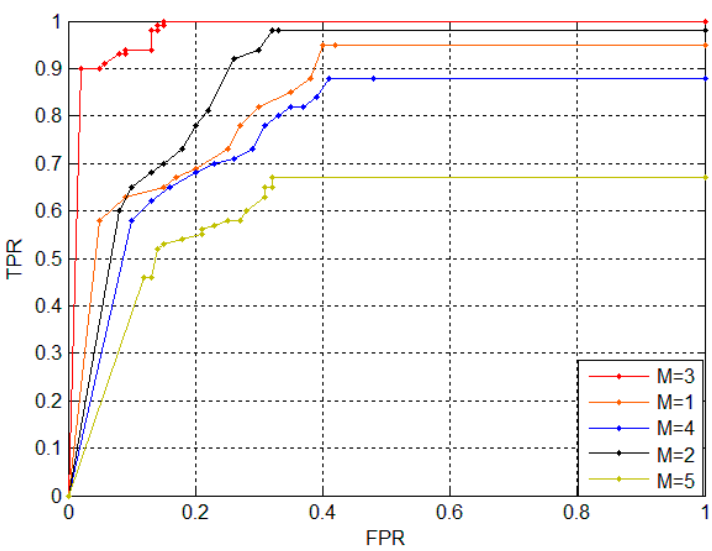
Figure 7. The relationship between M and ROC.